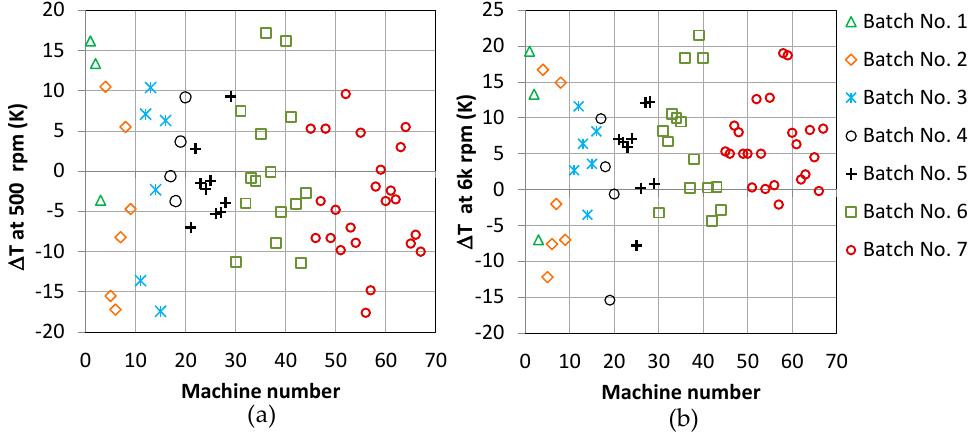
Figure 7. Temperature difference ( Δ T) between stators of the same motor. The difference is included at two different speeds: ( a ) 500 rpm; ( b ) 6000 rpm, both in thermally plateaued conditions.